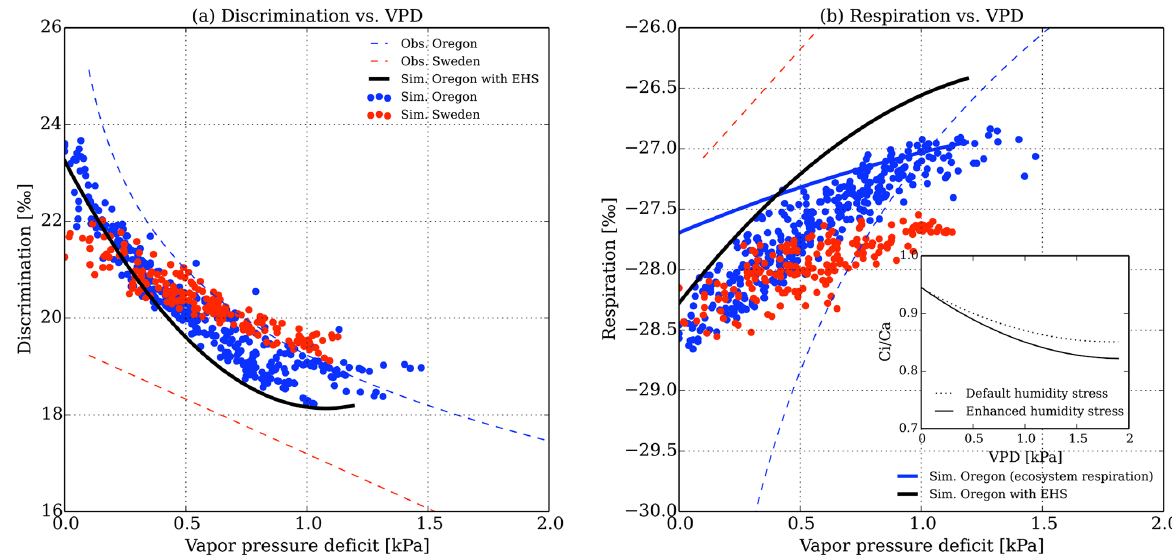
Figure 9. Modeled plant discrimination (‰) and isotopic signature in respiration (‰) as a function of the vapor pressure deficit (VPD, kPa) for two locations: Oregon (blue) and Sweden (red). (a) shows discrimination versus VPD. (b) shows the isotopic signatures in autotrophic respiration ( δ r ) versus VPD. The daily mean values are from the SiBCASA-ISOVAR simulation performed for the months in 2000, 2001, and 2002 when carbon uptake peaked. The daily mean VPD is derived from daylight hours. In (b) the blue dashed line represents a logarithmic fit to measured δ r taken from sites in Oregon (Bowling et al., 2002). The red dashed line represents a linear fit to measured δ r in a mixed coniferous boreal forest in northern Sweden (Ekblad and Hogberg, 2001). In (a) both lines are approximated as plant discrimination using the relationship 1 = δ a − δ r . The solid lines represent curve fits through simulated values at Oregon for ecosystem respiration (blue) and δ r / 1000 + 1 for enhanced humidity stress (black). The inserted panel in (b) shows the change in C i /C a ratio as a function of VPD due to this additional